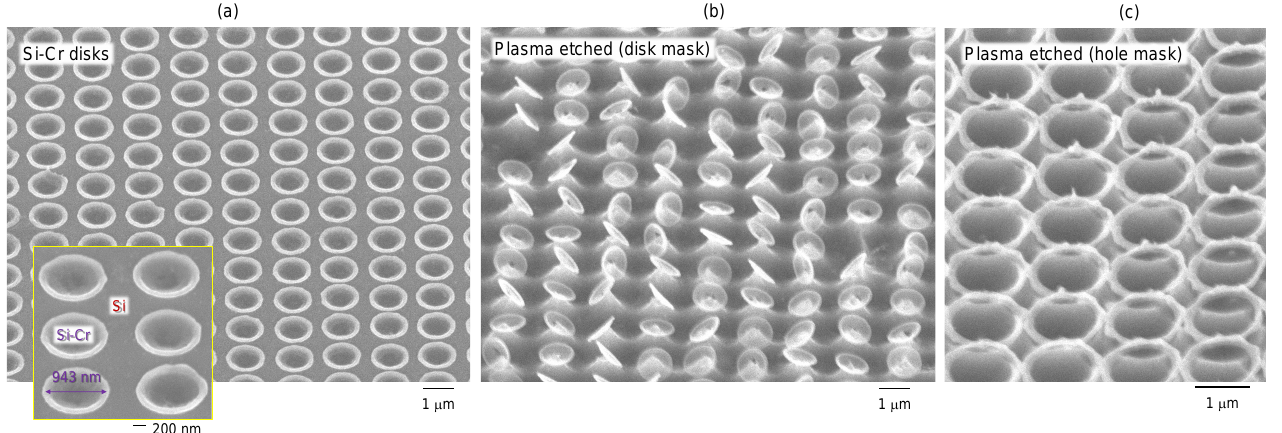
Figure 5. ( a ) SEM image of the Si–Cr alloy disk formed on the Cr film (30 nm), imaged after Cr-etch. Pulse energy E p = 3 nJ. ( b ) SEM images of Si-Cr disks used as dry plasma etch mask followed by Cr-etch. ( c ) SEM image of Si-Cr rings used as dry plasma etch mask followed by Cr-etch. Laser patterning was carried out with NA = 0.75; diffraction limited focal diameter 1.22 λ / NA = 838 nm; wavelength λ = 515 nm. Plasma etch was for 5